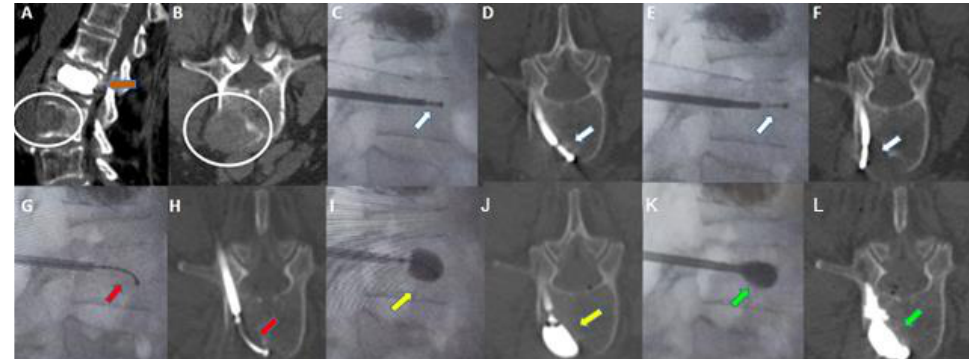
Figure 3. Sixty-eight-year-old woman with a history of breast cancer. ( A , B ): Sagittal ( A ) and axial ( B ) contrast-enhanced CT scan showing a metastatic lytic lesion of the left anterolateral portion of the L3 vertebra extending to adjacent perivertebral soft tissues (white circle in ( A , B )). Previous vertebral augmentation treatment with Arcadia in L2 (orange arrow in ( A )). ( C , D ): Fluoroscopy in the lateral plane ( C ) and axial CT scan ( D ). Placement of the STAR™ radiofrequency probe (white arrow) in the central portion of the lesion. ( E , F ): Fluoroscopy in the lateral plane ( E ) and axial CT scan ( F ). Placement of the STAR™ Radiofrequency steerable probe (white arrow) in the lateral aspect of the lesion. ( G , H ): Fluoroscopy in the lateral plane ( G ) and axial CT ( H ). Arcadia™ low compliance high pressure steerable balloon was inserted coaxially into the introducer cannula and deployed into the lesion (red arrow). ( I , J ): Fluoroscopy in the lateral plane ( I ) and axial CT ( J ). Arcadia™ low compliance high pressure steerable balloon gently inflated with a mixture of saline and iodinated contrast, with the intent of compacting the ablated tissue and creating a void for cement delivery (yellow arrow). ( K , L ): Fluoroscopy in the lateral plane ( K ) and axial CT ( L ). StabiliT ® high viscosity bone cement was slowly delivered into the lesion for the stabilization of the vertebral body (green arrow).